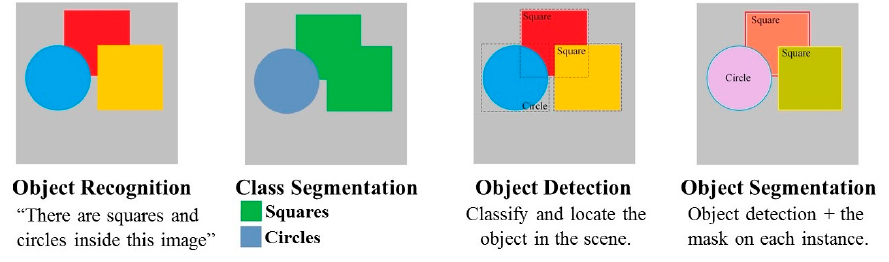
Figure 5. Typical image processing task.